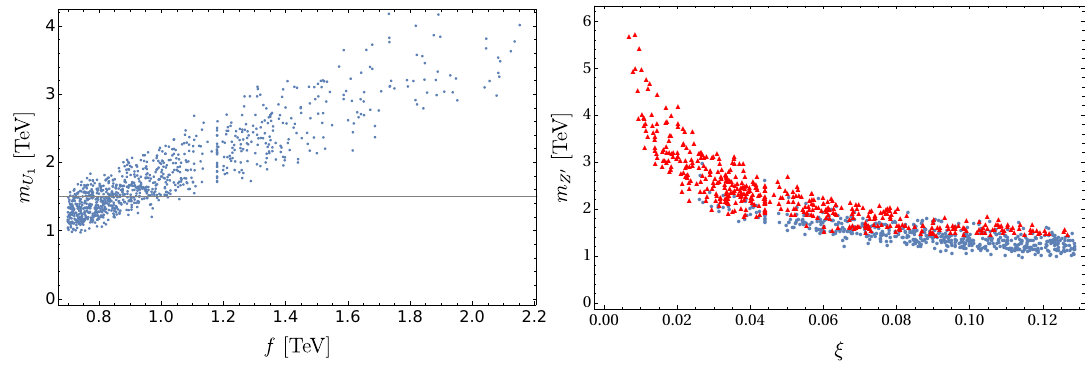
Figure 4 . On the left panel we show a scatter plot of mass of the vector leptoquark U 1 , as a function of the Higgs decay constant f , for the benchmark region. We observe the predicted linear dependence with f . Also pictured is the line at 1.5 TeV, often cited as a bound for its mass in direct searches [79]. On the right panel we show a scatter plot of mass for the (cid:12)rst Z 0 resonance, as a function of (cid:24) = v 2 =f 2 , for points on the benchmark window. Red triangles pass the experimental SM constraints, whereas blue circles do